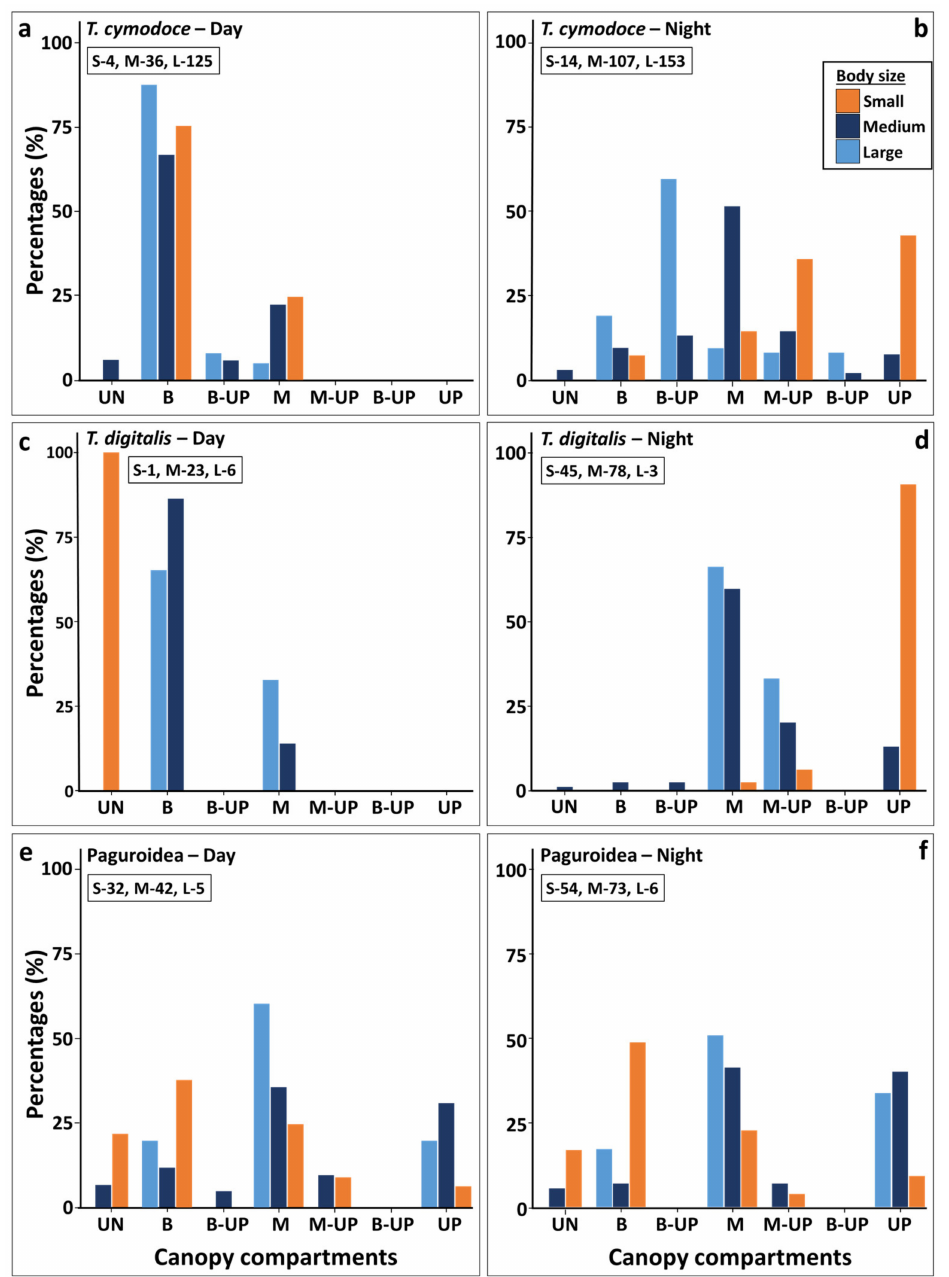
Figure 5. Proportion of three S. pistillata dwelling crustacean species according to their distribution between canopy compartments and their body-size groups during day and night censuses (left and right graphs, accordingly). ( a , b ) T. cymodoce; ( c , d ) T. digitalis; ( e , f ) Paguridae. Individual total observations by their size (L large, M medium, S small) are marked for each plot. Percentage was calculated according to the total abundance of each species size group for each day time census (UN) understory; (B) base; (M) middle; (B-UP) base, middle, and up; (M-UP) middle and up